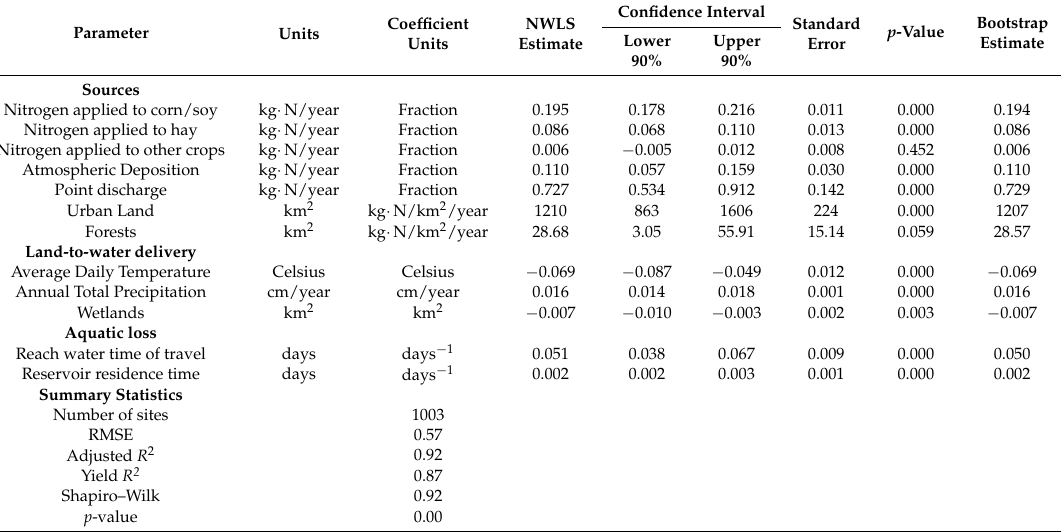
Table 2. SPARROW calibration results of sources of nitrogen, delivery and decay variables.